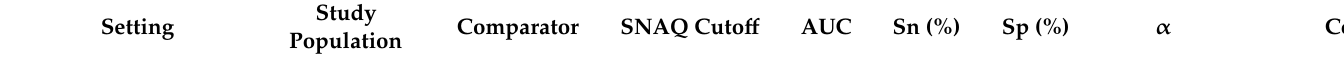
Table 1. Summary of Simplified Nutritional Appetite Questionnaire (SNAQ) Studies